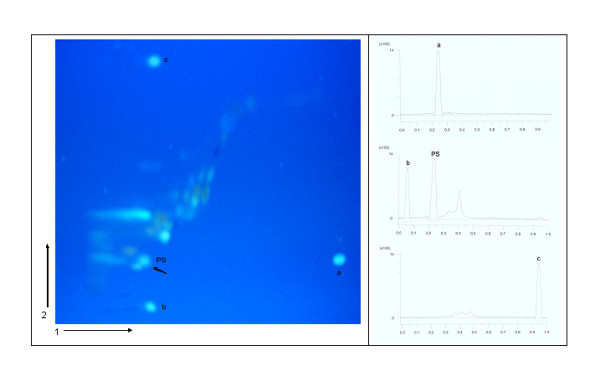
2D-TLC of caffeic acid in propolis sample from Peruča and standards of caffeic acid. The plate was first developed in the direction 1 then 2 using mobile phase 1 (n-hexane : ethyl acetate : glacial acetic acid = 31 : 14 : 5 v/v) and mobile phase 2 (chloroform : methanol : formic acid = 44 : 3.5 : 2.5 v/v). Bands were visualized under short and long wave UV light and under long wave UV light after spraying with 1% AlCl3 ethanol solution. Concetration obtained from chromatograms: a = mmax = 2.50 μg, b = mmin = 0.83 μg, c = mmid = 1.67 μg, PS = mpropolis sample = 2.91 μg [18].